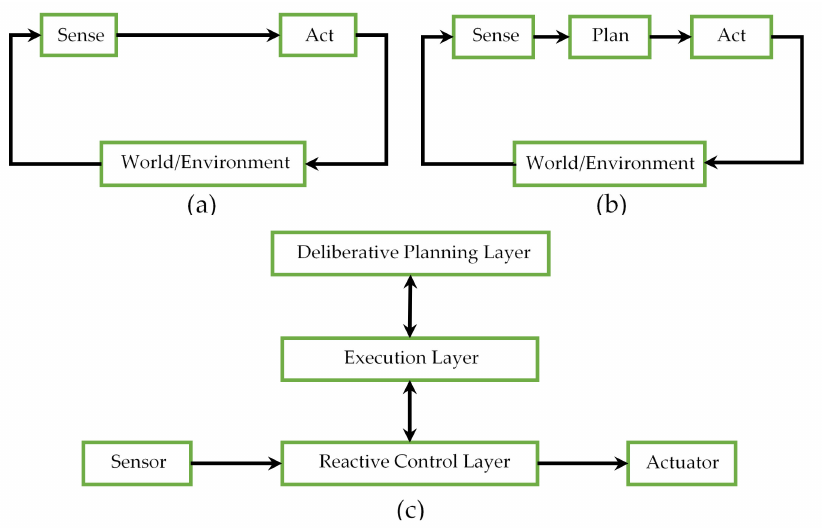
Figure 8. ( a ) Reactive control architecture; ( b ) deliberative planning architecture; ( c ) hybrid control architecture